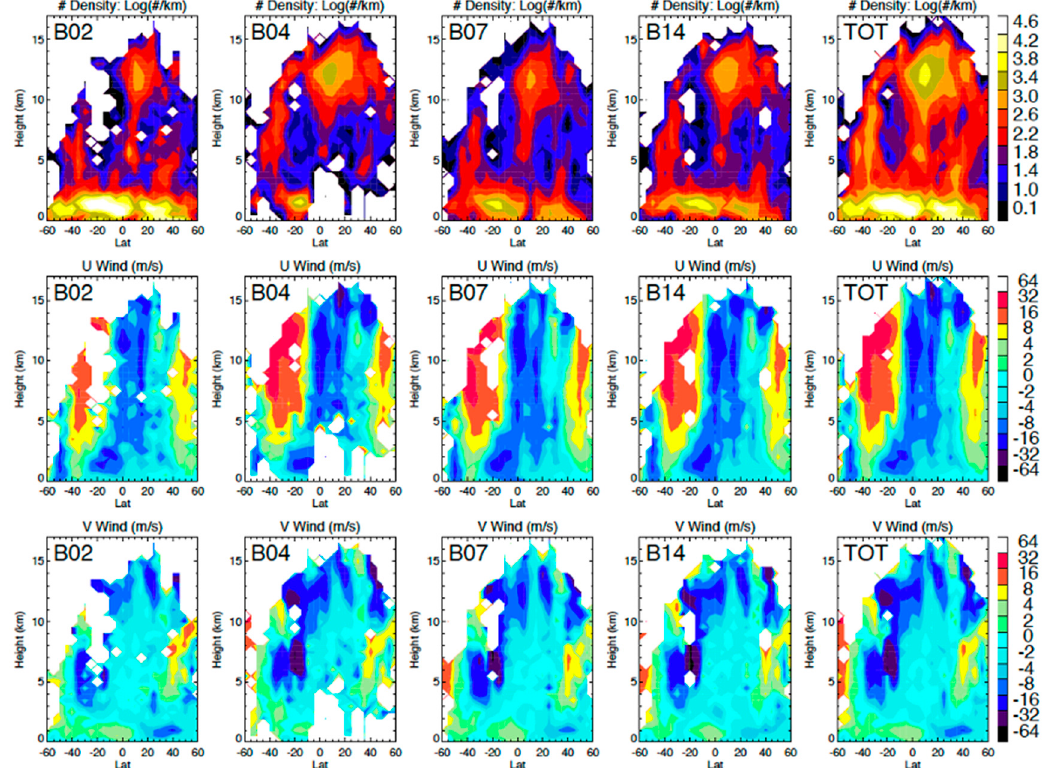
Figure 13. Zonal mean distributions of cloud height and u - and v -wind retrievals (as in Figure 11) for the four spectral bands as a function of latitude and altitude. The TOT is the averaged zonal mean of the results from four spectral bands for the entire domain of FD–FD retrievals.